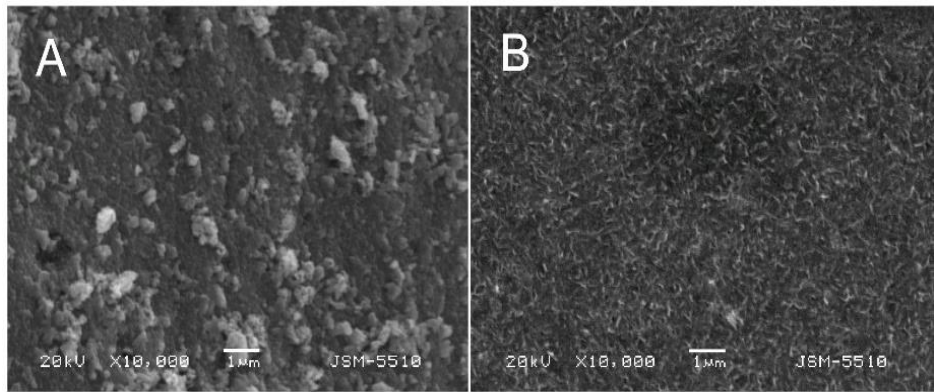
Figure 2. SEM micrographs of hybrid CuO-containing coatings: ( A ) CuO nanoparticles before electrodeposition of ordinary zinc; ( B ) final coating after zinc electrodeposition.